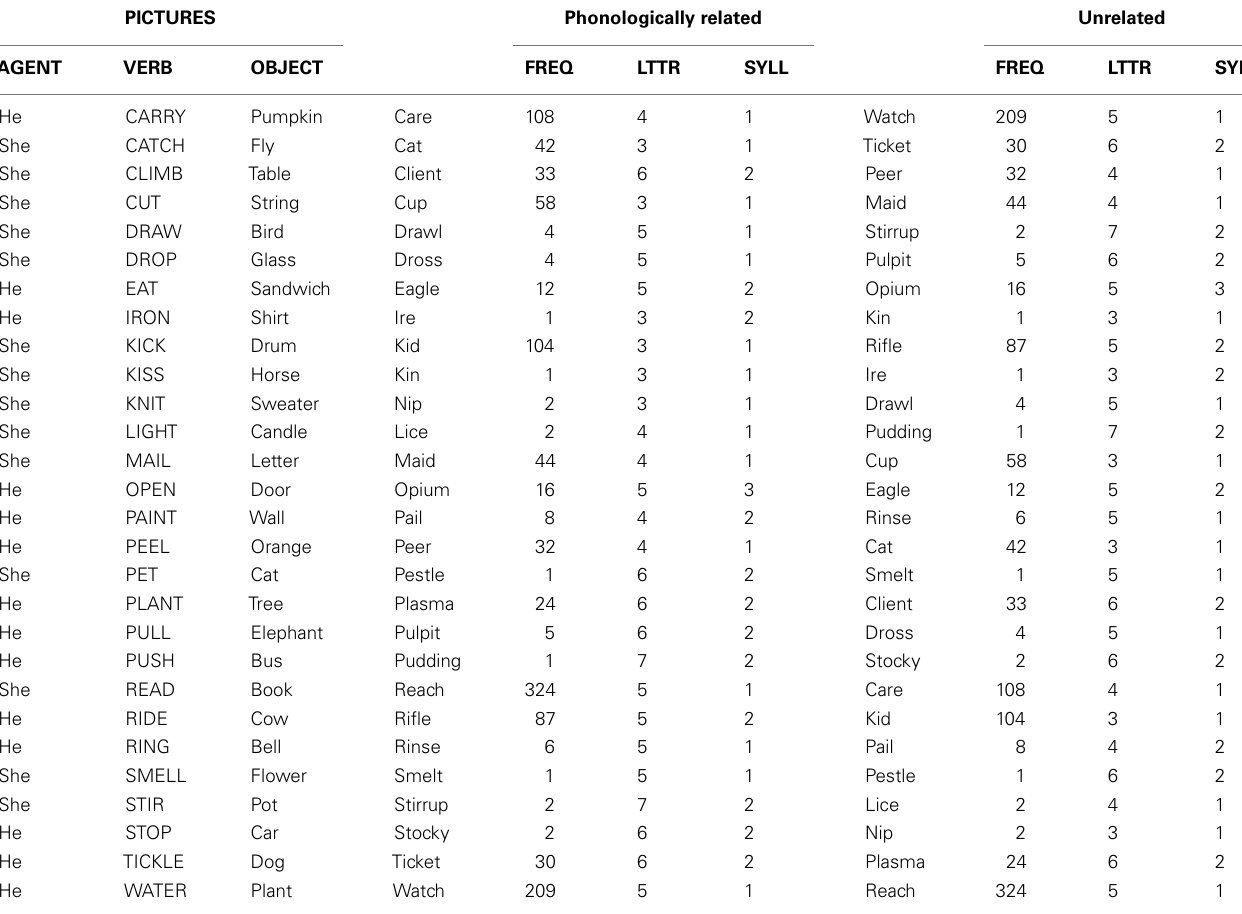
TableA1 | Stimuli for Experiment 1. Frequency (FREQ), letter length (LTTR), and number of syllables (SYLL) of the written distractors paired with the target